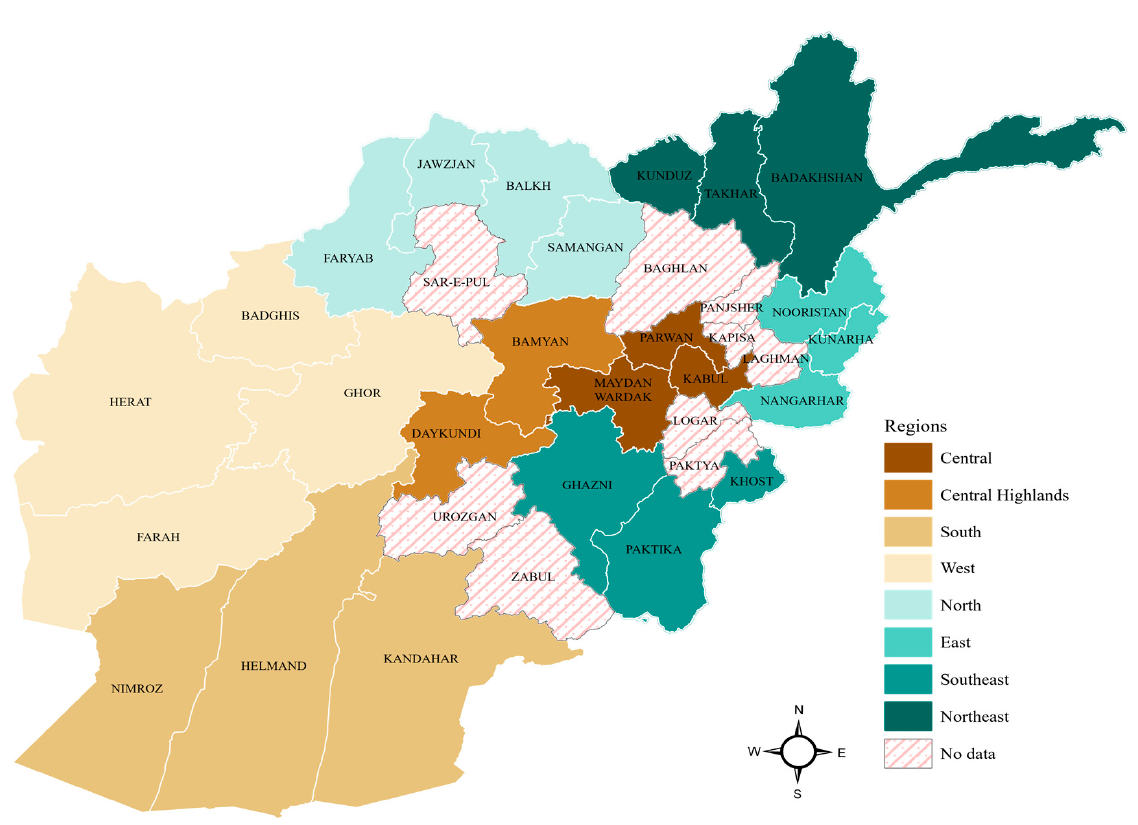
Figure 1. Provinces within the regions of Afghanistan included in the study sample. Table 1. FIES